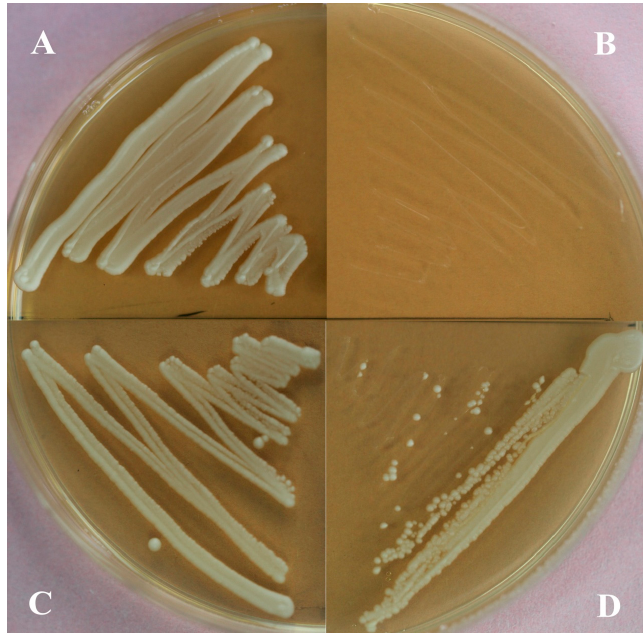
Figure 4. Functional complementation for the growth of the yeast strain YSC6274. ( A ) Diploid YSC6274 on YPD + G418 medium grew within 2 days; ( B ) Haploid YSC6274 containing pYES2-TwHMGS on YPD + G418 medium failed to grow; ( C ) Diploid YSC6274 on YPG + G418 medium grew within 2 days; ( D ) Haploid YSC6274 containing pYES2-TwHMGS on YPG + G418 medium grew within 3 days.